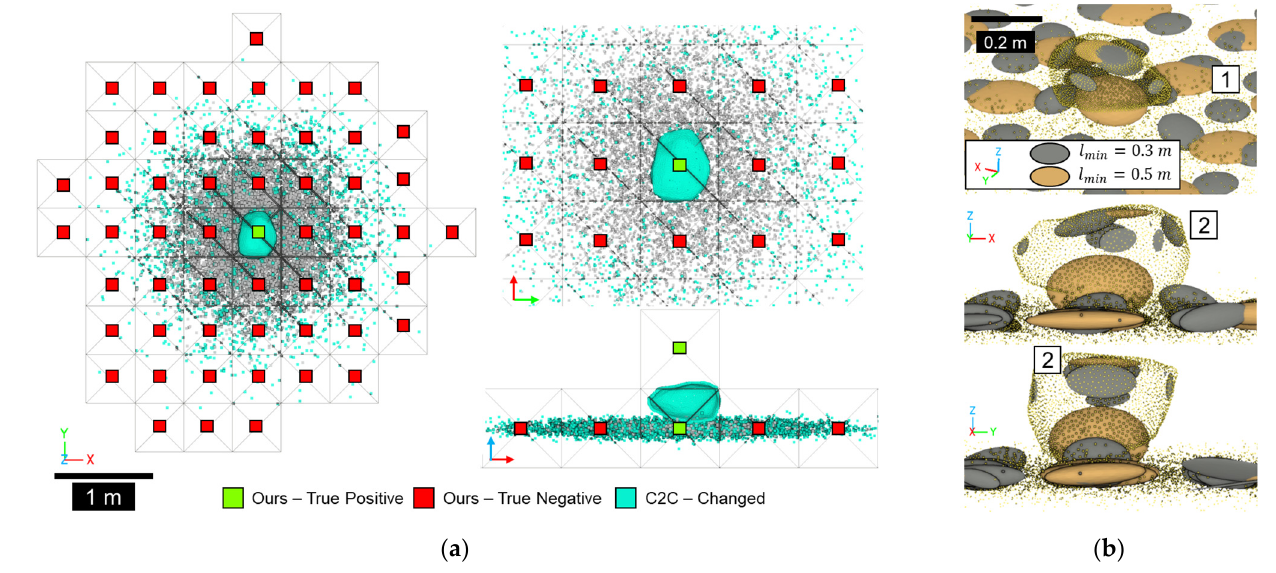
Figure 8. Plan and section views of SDS2 E1 and E2 with a 0.4 × 0.3 × 0.25 rock appearing in E2 and 0.5 m voxels for C2C and our approach ( a ). Top-down and side view of SDS2 and voxel-ellipsoid representation based on 0.5 m (brown) and 0.3 m (grey) minimum voxel size ( b ). Both l min values create good ellipsoid representations of the floor (1). Smaller voxels generate more detailed ellipsoid representations of rock (2).